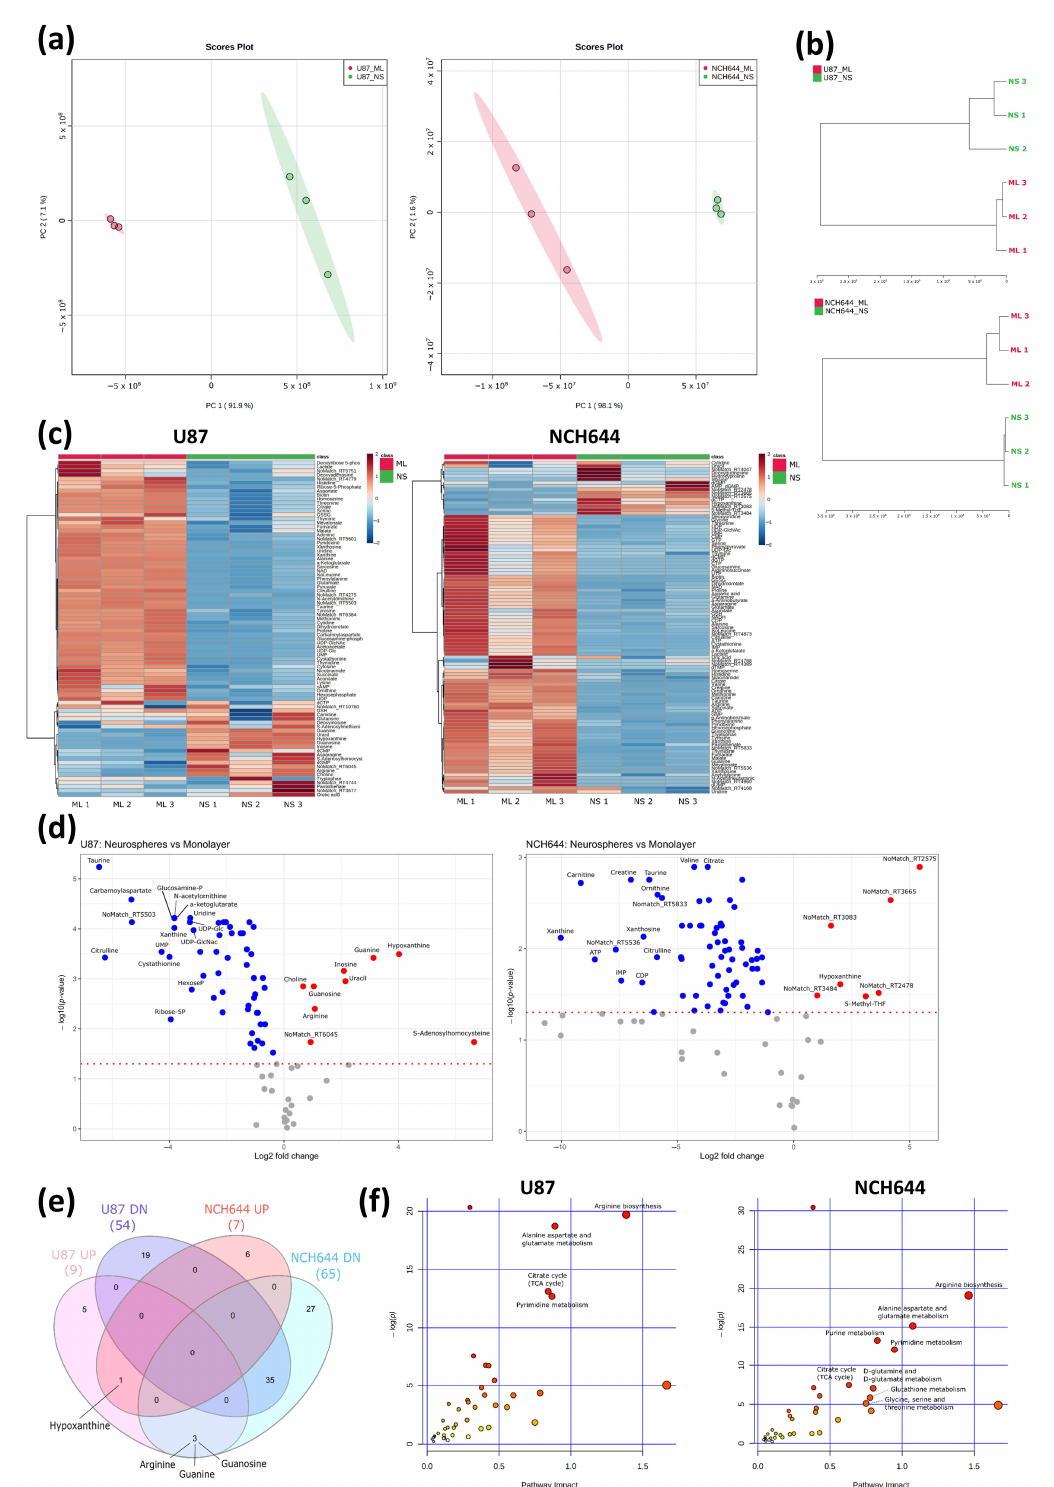
Figure 4. Metabolomics analysis of ML and NS from U87 and NCH644 cells. ( a ) Principal component analysis and ( b ) hierarchical clustering of all metabolites, showing a clear separation between ML and NS samples in both cell lines. ( c ) Heatmaps and ( d ) volcano plots of increased (red) and decreased (blue) metabolite levels in NS vs. ML from U87 and NCH644 cells (FDR < 0.05). ( e ) Venn diagram depicting the number of significantly increased (UP) and decreased (DN) metabolites in NS vs. ML, as well as commonly and differentially regulated metabolites between U87 and NCH644 cells (FDR < 0.05). ( f ) Metaboanalyst analysis of significantly regulated metabolites in NS vs. ML from U87 and NCH644 cells (FDR < 0.05, Pathway impact > 0.5); n =